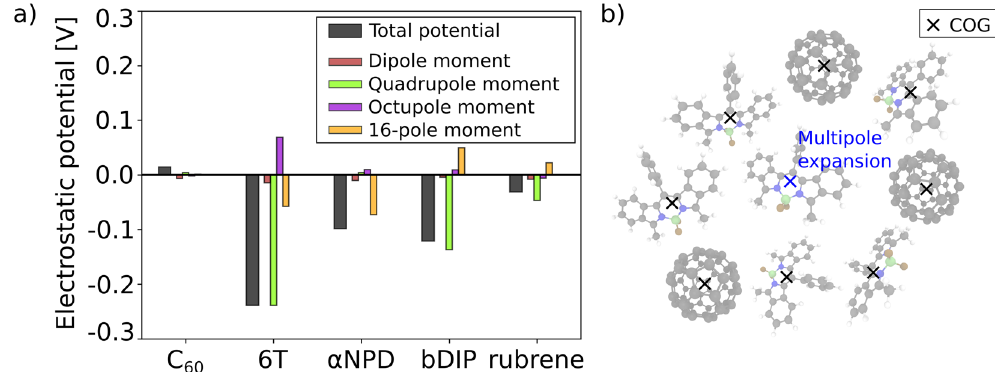
Figure 4. ( a ) Sum of the electrostatic potential created by the (guest) molecules at the center-of-geometry (COG) positions of the thirty nearest neighbors (see panel b)). Albeit having no net charge (monopole moment), the guest molecules (in particular 6T and bDIP) create a negative electrostatic potential which causes the shift of the energy levels of both guest and host (C 60 ) molecules as observed in experiment and simulations (see Fig. 2). A multipole analysis identifies the electrostatic moments responsible for the energy level